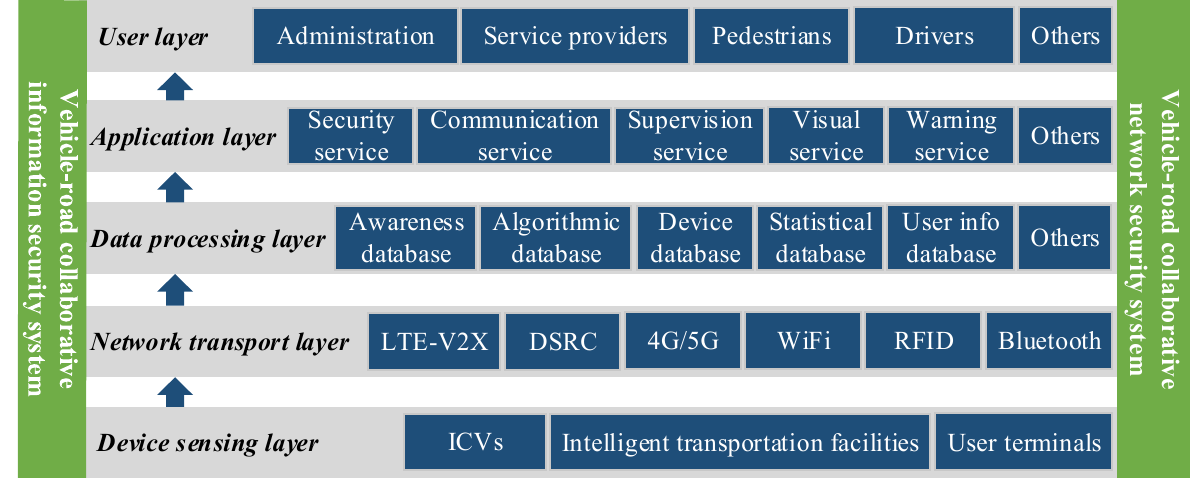
Figure 7. Overall architecture of extended CWS from the perspective of smart PSS.